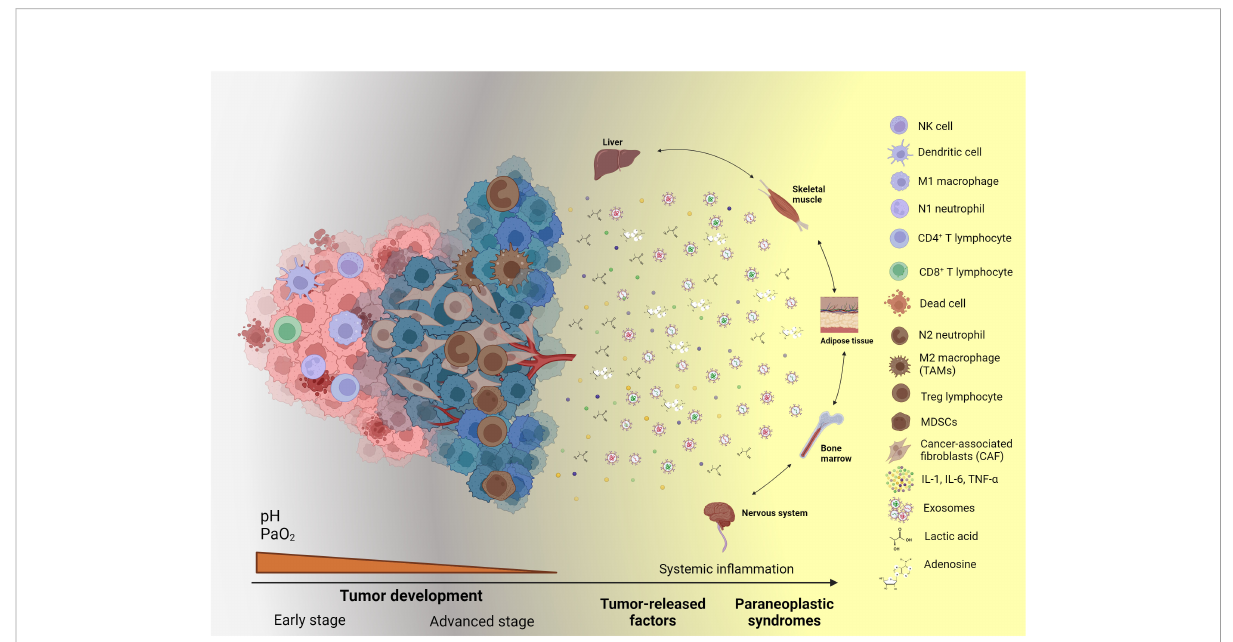
FIGURE 1 Systemic effects and paraneoplastic syndromes caused by cancer-associated in fl ammation. During the advanced stages of tumor development, tumor and stromal cells release an array of soluble factors, such as cytokines, chemokines, growth factors, metabolic by-products, exosomes, and ncRNAs, which sustain the local in fl ammatory state. Moreover, these soluble factors, when released into the bloodstream, reach distinct organs, systems, and tissues, causing alterations in their function and the production of diverse molecules and subsets of cells, which can be employed as biomarkers to assess cancer-related systemic in fl ammation. Created with